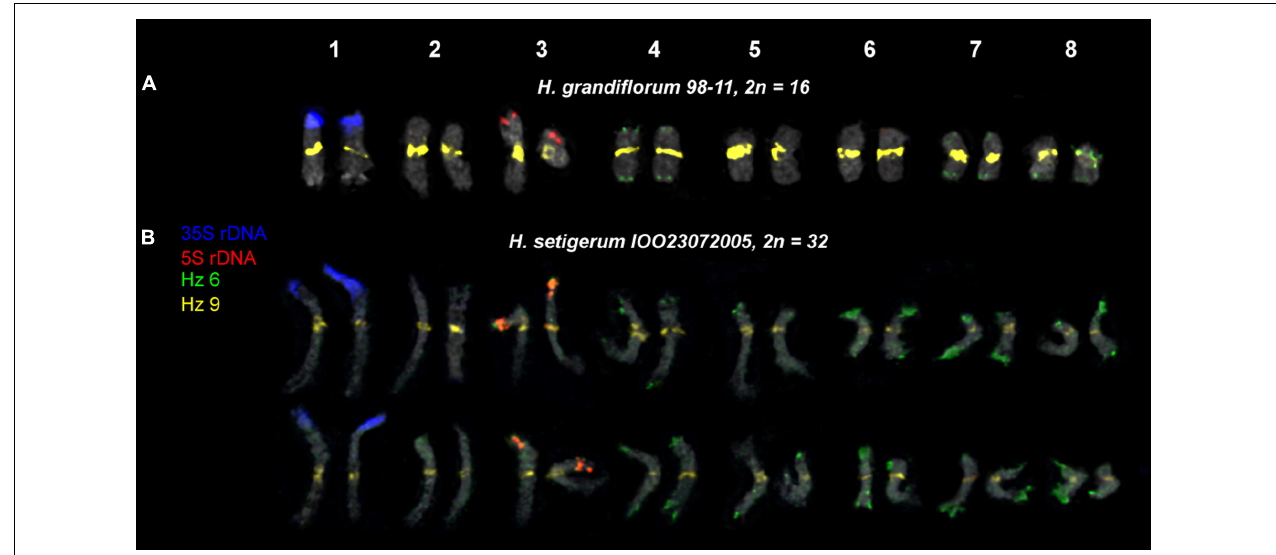
FIGURE 7 | Karyotypes of the studied accessions of H. grandiflorum (A) and H. setigerum (B) after FISH with 5S rDNA, 35S rDNA, and satellite repeats Hz 6 and Hz 9 (the same metaphase plates as in Figures 3 , 4 ). The correspondent probes and their pseudocolors are specified on the